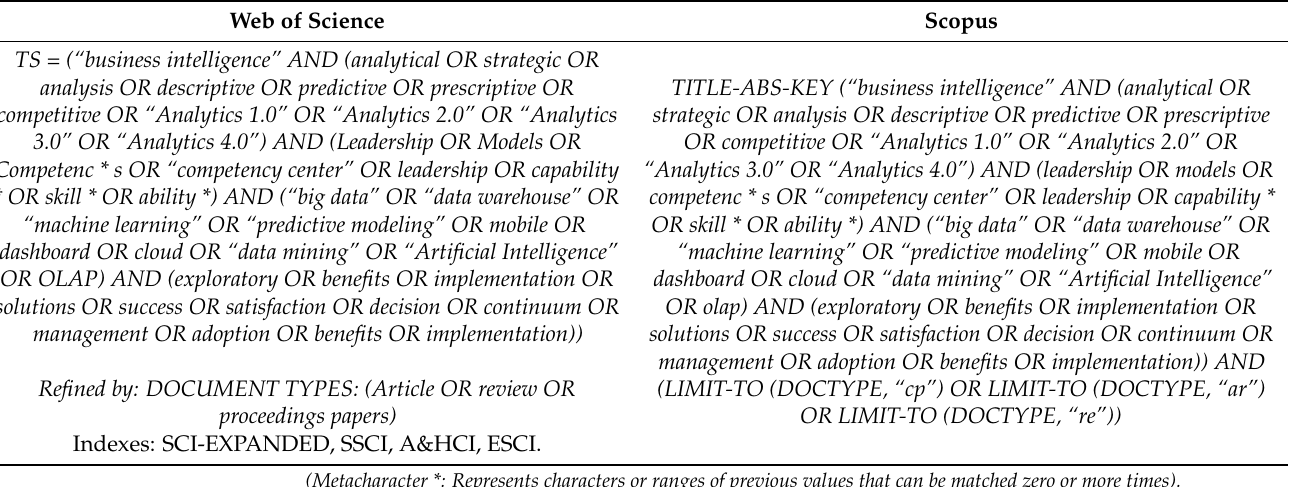
Table 3. Advanced search equation for each bibliographic database. Web of Science Scopus